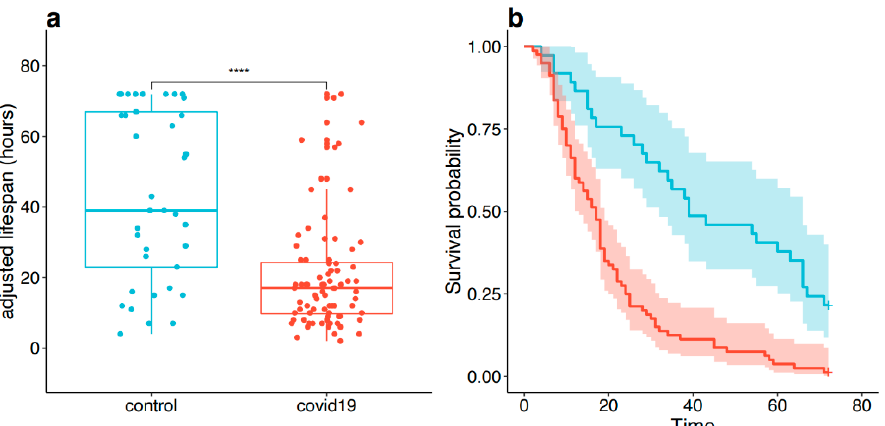
Figure 2. Filter lifespan. ( a ) adjusted filter lifespan in control (blue) and COVID-19 (red) groups shown as boxplot with median and interquartile range. ( b ) survival curves displaying adjusted filter lifespan among COVID-19 (red) and control (blue) groups. **** p <